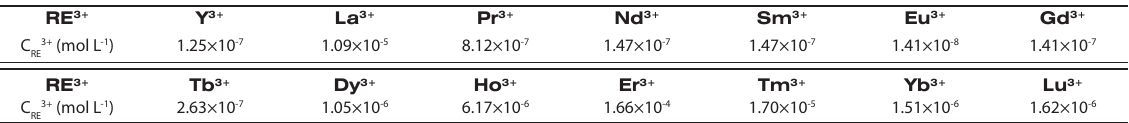
Table 1. The determination of the concentration of RE 3+ (C RE3+ / mol L -1 ) when ∆T = -0.2